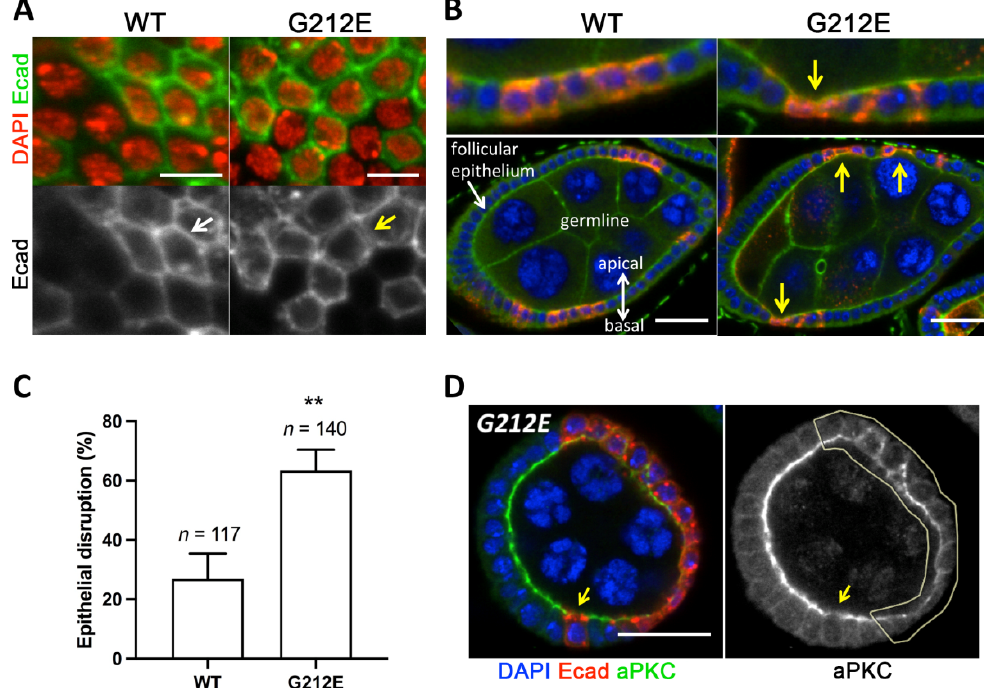
Figure 5. Structural features of human G212E variant in Drosophila epithelia. ( A ) Surface views of the Drosophila follicular epithelium with mosaic clones expressing human wild-type CDH1 and the G212E variant using the FLPout/tub-GAL4 system. Cells expressing G212E E-cadherin display weaker accumulation at the plasma membrane (arrows). E-cadherin is shown in green, and DAPI (red) labels the nucleus. Scale bars represent 5 µ m. ( B ) Longitudinal view of egg chambers stained for E-cadherin (red), actin (green) and DAPI (blue). Clones expressing G212E lead to epithelial invaginations with consequent tissue disruption (arrows). Upper images are close-ups of the lower ones. Scale bars represent 20 µ m. ( C ) Quantification of disrupted epithelial architecture caused by the overexpression of wild-type and mutant E-cadherin in the Drosophila follicular epithelium. Data derives from four independent experiments. For each experiment, around 30 clones were quantified per genotype (total number in the graph). Graph displays mean + SE; ** represents p ≤ 0.01 for a two-tailed paired t-test. ( D ) Longitudinal section of an egg chamber with a large clone of cells expressing the G212E mutant (red) and stained for the apical marker aPKC (green). Loss of apico-basal polarized localization is evident even in a single cell overexpressing G212E (arrow). Scale bar represents 20 µ